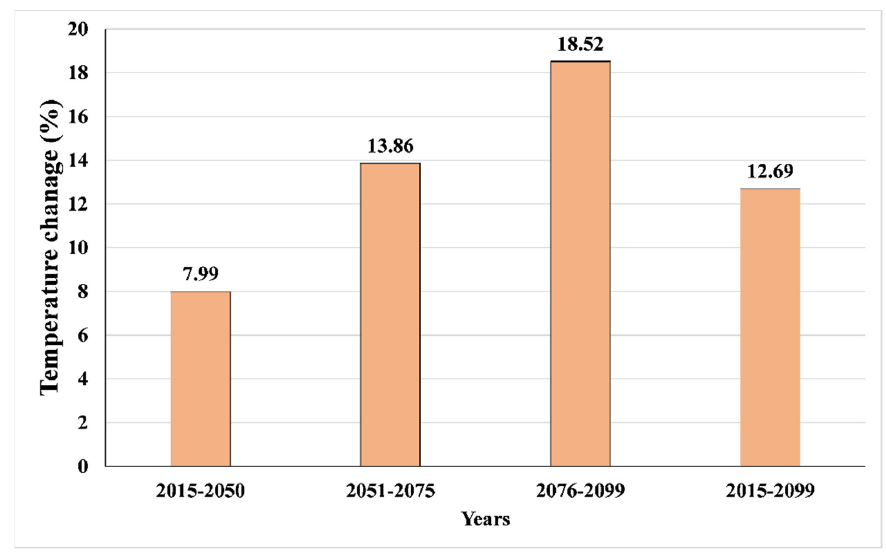
Figure 6. The annual temperature changes in Egypt between the past period (1950–2014) and the future period (from 2015 to 2099).